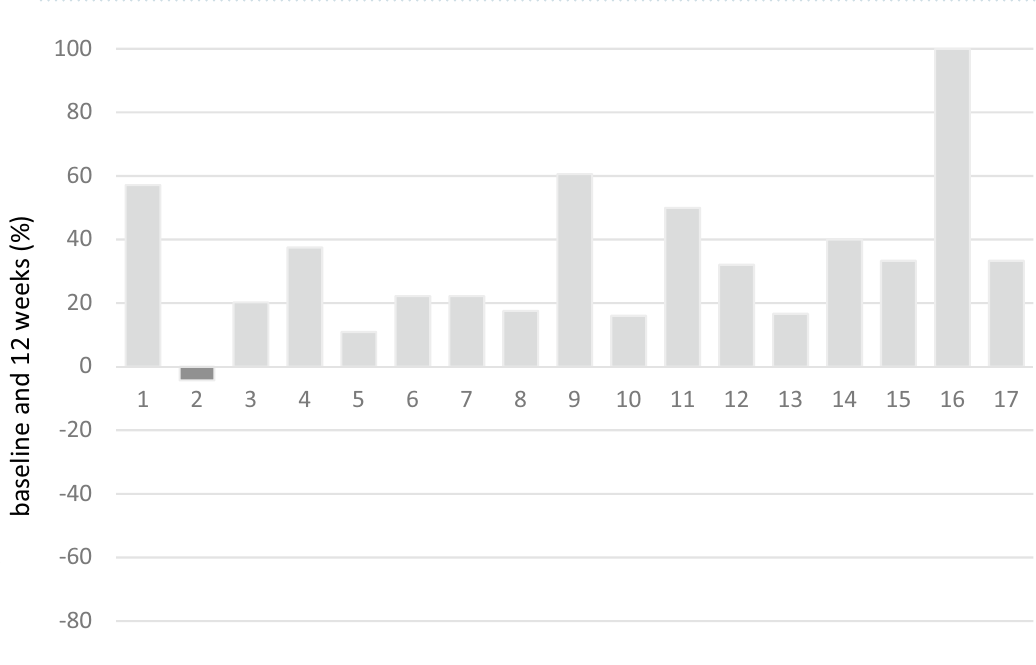
Figure 3. Average duration of aerobic exercise per session, in minutes for 20 participants. (Dashed line = 75% adherence or 22.5 min per session.)